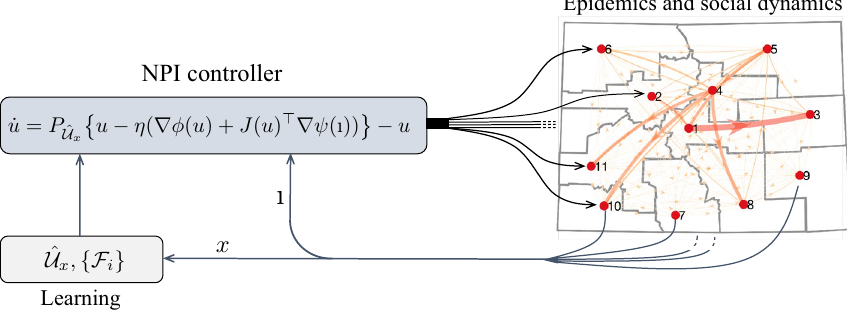
Figure 8. Implementation of the NPI controller. The example refers to the state of Colorado, where each region represents a Local Public Health